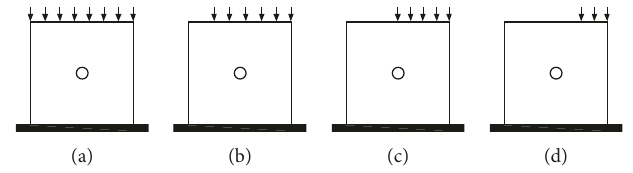
Figure 4: Realization of local loading. (a) S, (b) 3S/4, (c) 2S/4, and (d) 1S/4.